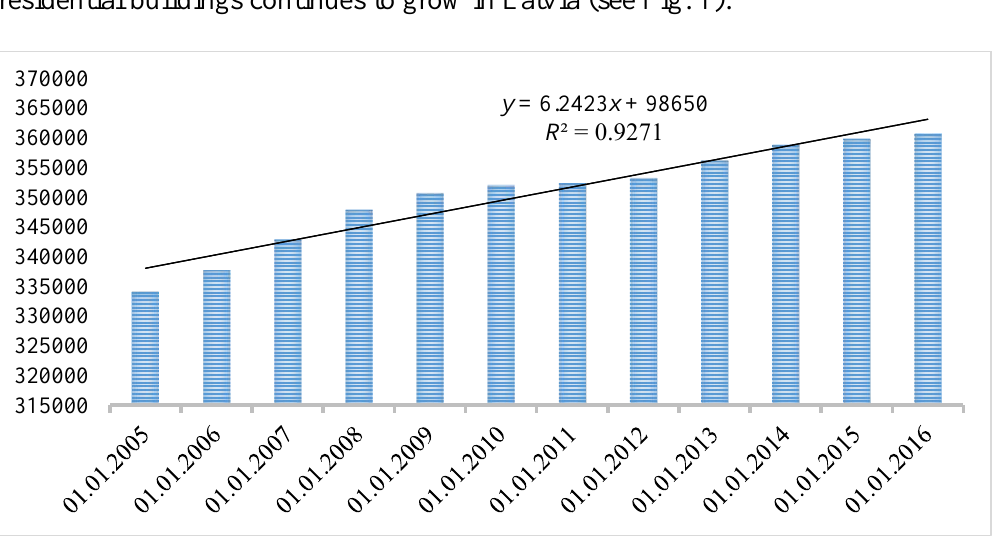
Fig. 1. Dynamics of changes in the number of residential buildings in Latvia [2005–2016], (State Land Service,